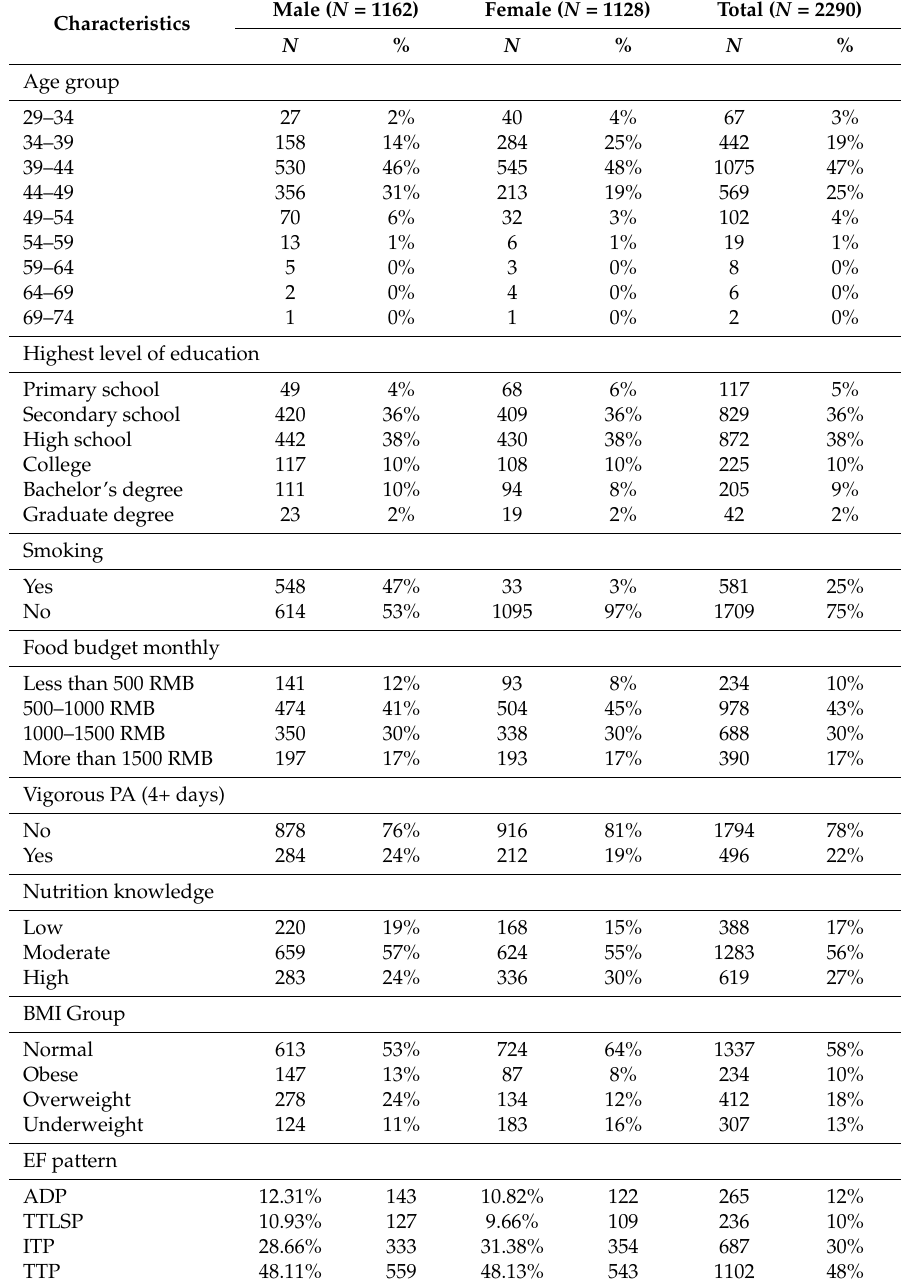
Table 1. Characteristics of the study population ( N =